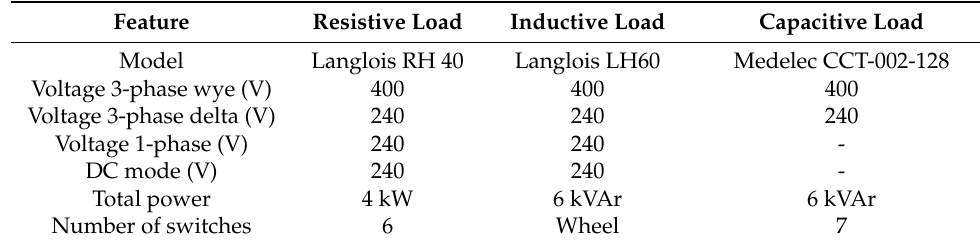
Table 8. Features of the